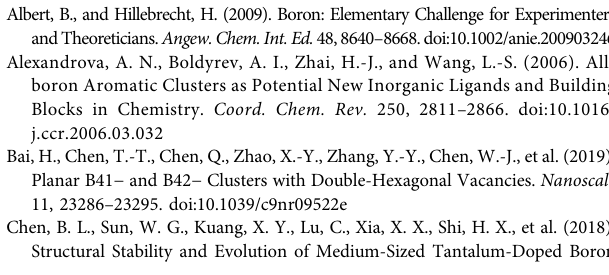
Frontiers in Chemistry |